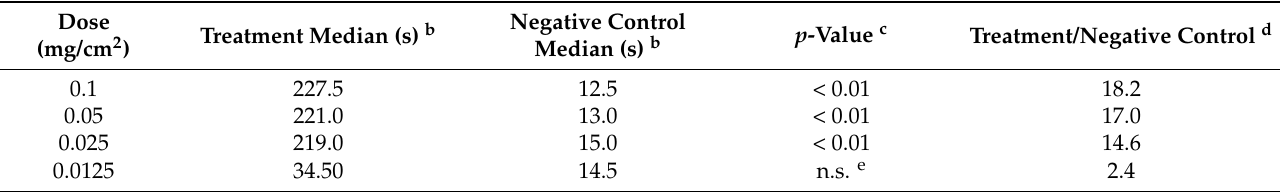
Table 1. Repellency of Armoracia rusticana root oil against Haemaphysalis longicornis nymphs at different doses using a filter paper bioassay a